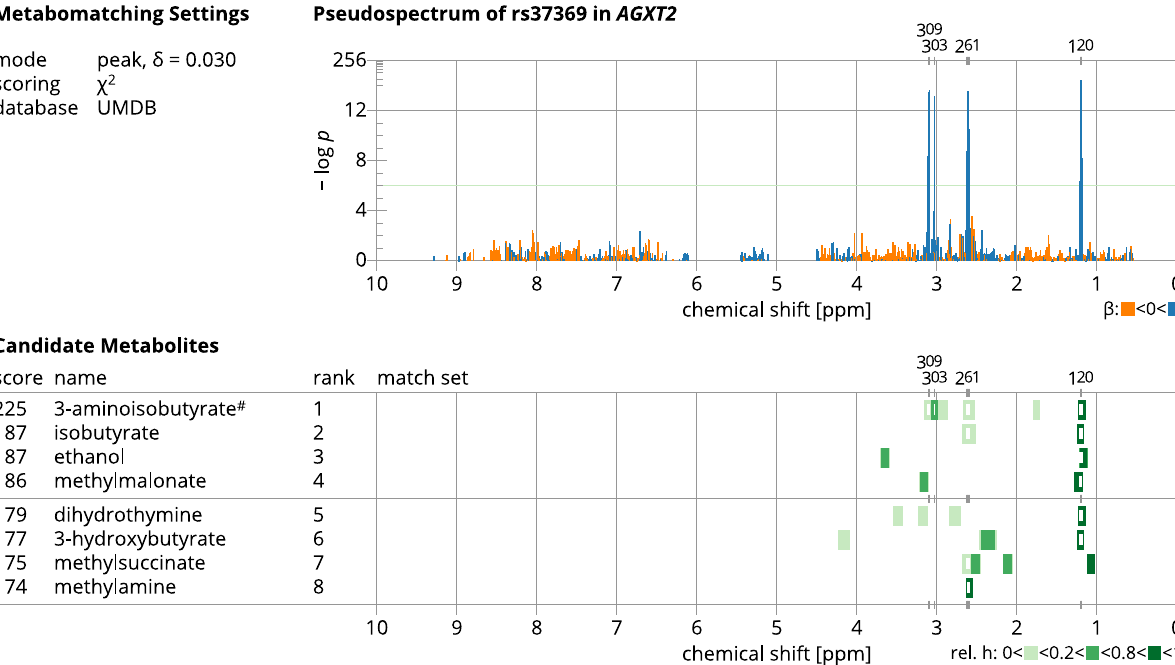
PLOS Computational Biology | https://doi.org/10.1371/journal.pcbi.1005839 December 1,